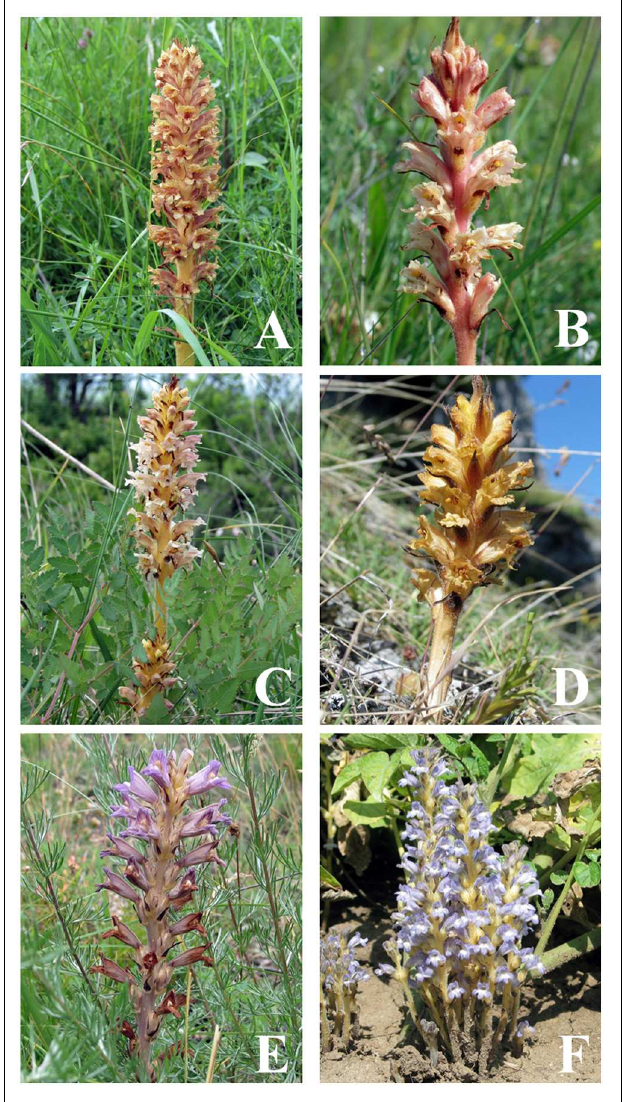
FIGURE 1 | Examples of some morphologically, taxonomically, and evolutionary difficult to distinguish broomrape species, (A) Orobanche elatior , (B) Orobanche kochii , (C) Orobanche alsatica , (D) Orobanche mayeri , (E) Phelipanche arenaria , and (F) Phelipanche